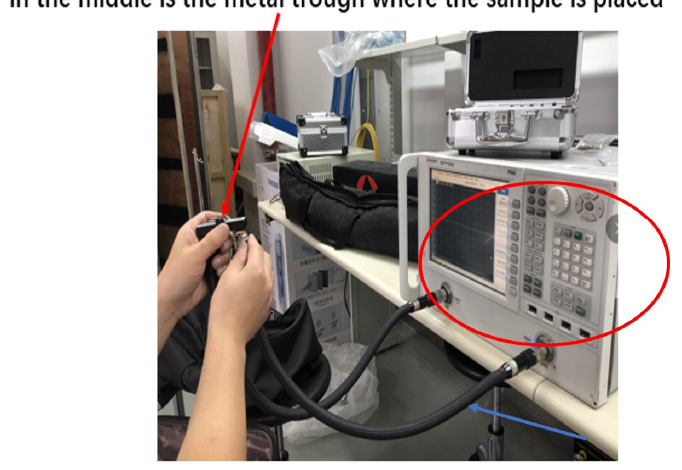
Figure 7. The transmission/reflection coefficient measurement system. Where the red arrow points is where the sample is placed. The instrument circled in red is a vector network analyzer (VNA). The blue arrow shows the coaxial